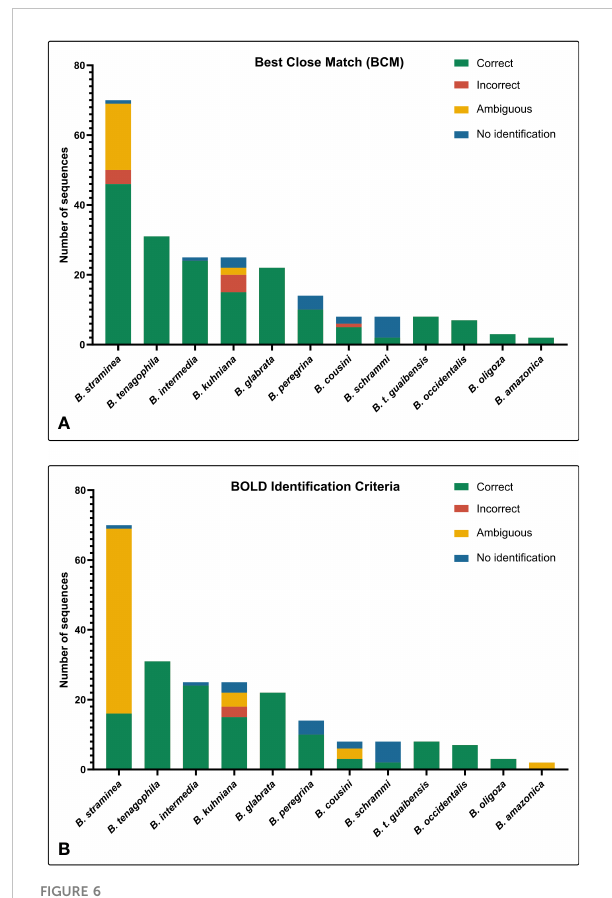
FIGURE 6 Distribution map and tree generated by Bayesian Inference of the Biomphalaria glabrata specimens used in this study. (A) Map with the geographical distribution of Biomphalaria specimens in Latin America. (B) Simpli fi ed phylogenetic tree obtained by Bayesian Inference (BI). The colors represent the large groups separated by the phylogeny of the